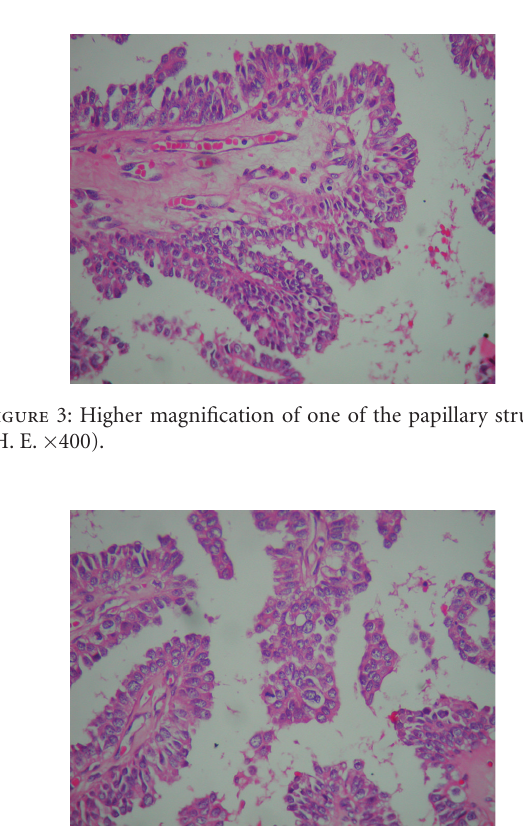
Figure 4: Multiple papillary structures with one in the center showing a mitotic figure (H. E. ×